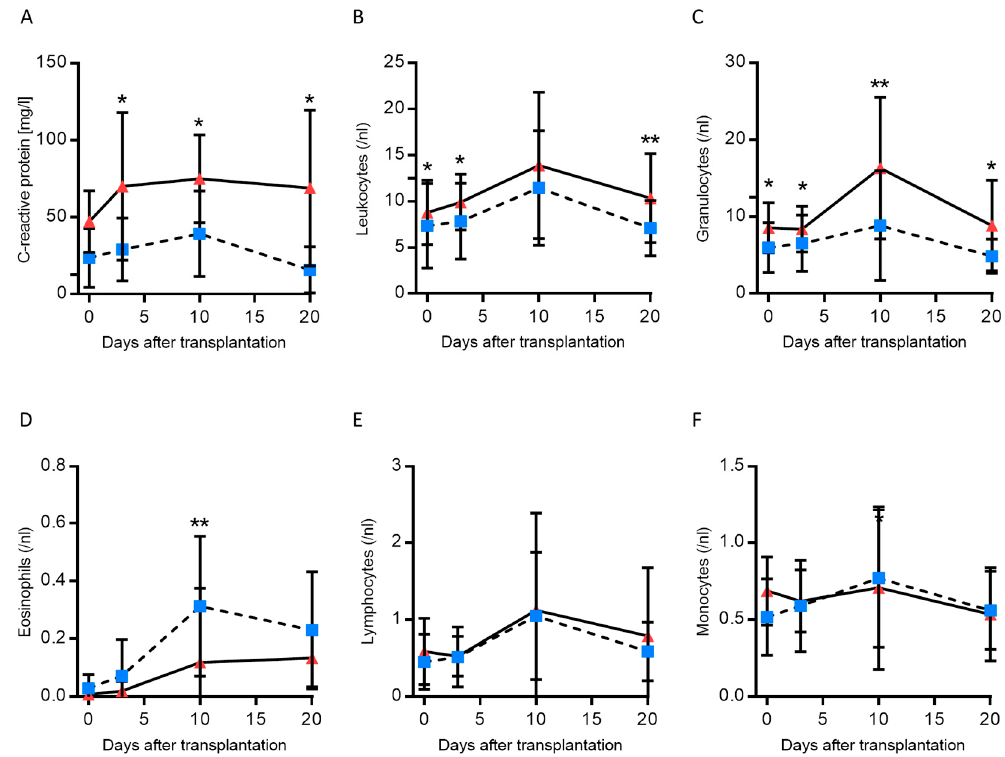
Figure 3. C-reactive protein, and differential blood count after liver transplantation ( n = 50). ( A − F ). Patients were classified according to cfDNA concentration (L1PA2 element, 90 bp, LINE sequence, non-coding). Mann–Whitney U test; * p < 0.05; ** p < 0.01.